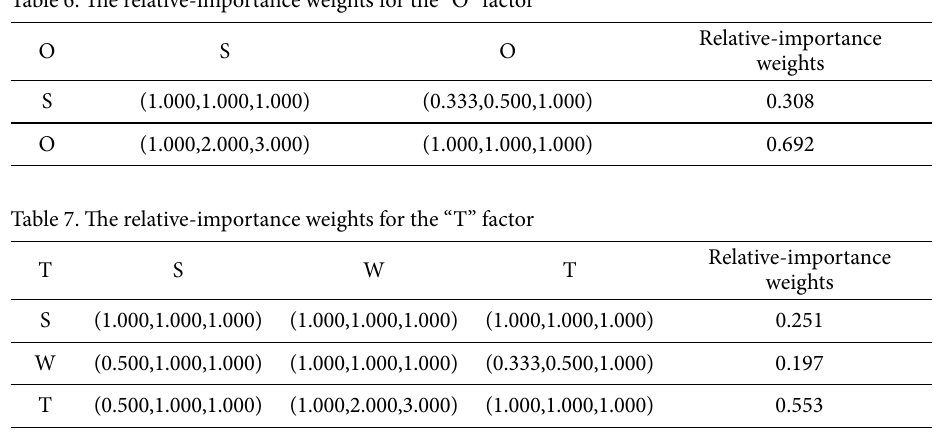
Table 6. The relative-importance weights for the “O” factor